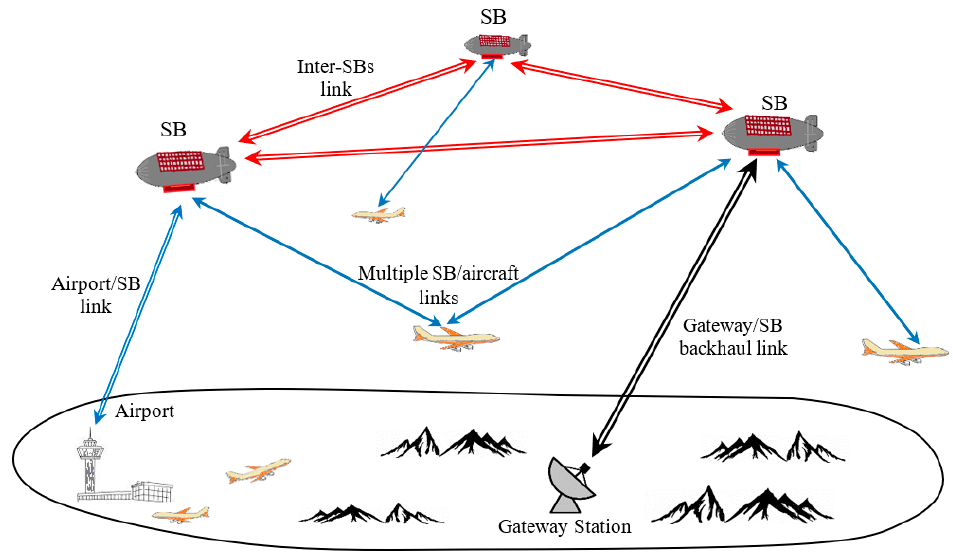
Figure 1. Stratospheric basestations wireless network for aviation.